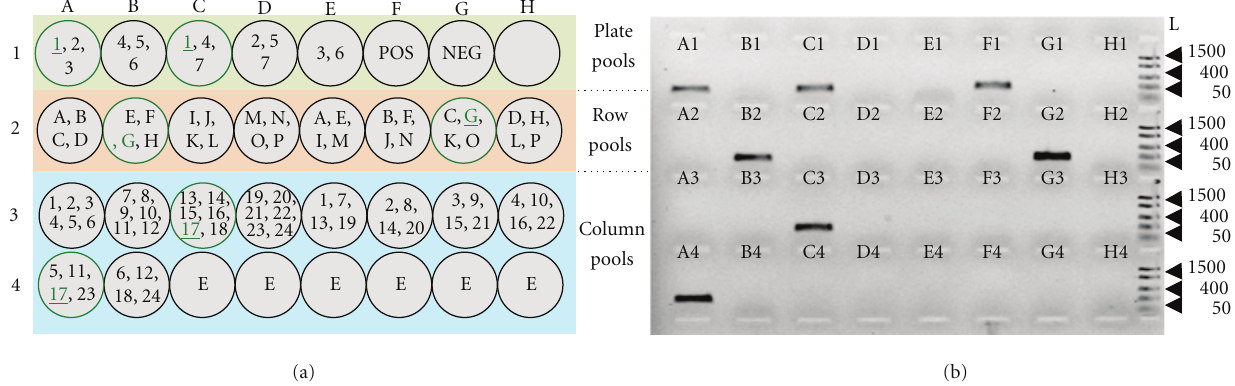
Figure 3: Results of matrix pool screening for the barley BAC library HVVMRXALLeA. (a) Schematic representation of a matrix pool composed of 23 pools for the BAC library HVVMRXALLeA [24]. The colored panels in A indicate the plate, row, and column matrix pools. Each circle represents a plate/row/column matrix pool where its composition is indicated within the circle. A matrix pool is composed of clones from seven 384 well BAC library plates. The clones within the seven plates are pooled based on a predefined matrix to form plate, row, and column matrix pools. A1—H4 indicate the position of each pool in a 96-well plate. NEG: negative control. POS: positive control, in this case genomic DNA of barley cultivar “Morex” where the BAC library was derived from. E: empty well. (b) Ethidium-bromide-stained agarose gel (1.5%) image of matrix pool screening. A1—H4 indicate the well position of each pool in the PCR plate. F1 is the positive control where G1 represents the negative control. Two signals are required to identify a given coordinate of the BAC address. Positive pools are highlighted by a green border and the shared coordinates between positive pools are underlined in (a). Arrowheads indicate in each panel the position of the 1500, 400, and 50bp fragments of the FastRuler Low Range marker. L (size standard in